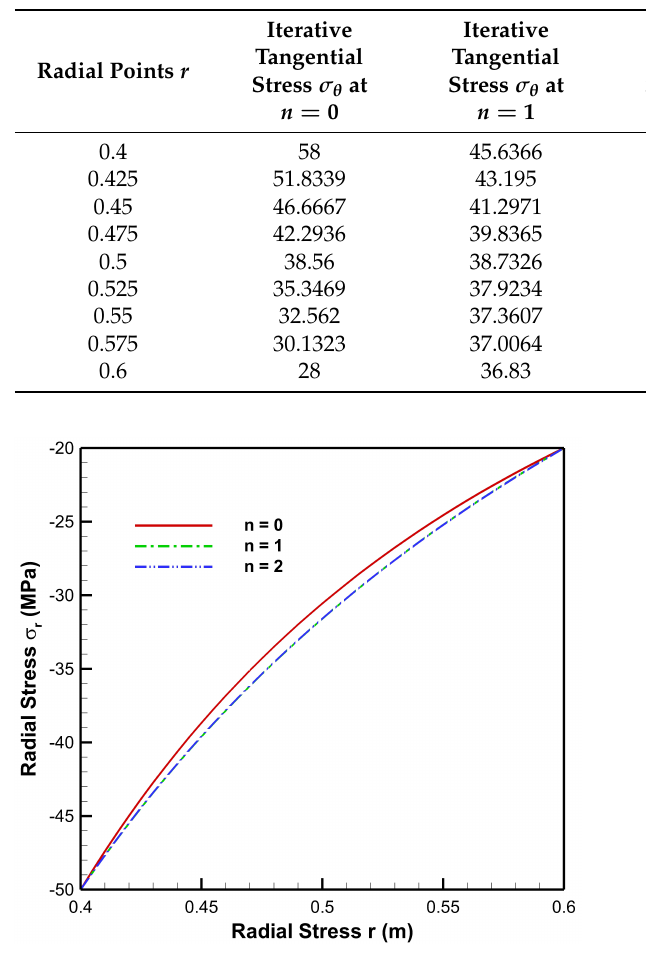
Figure 19. Iterative radial stress σ θ in FGM cylinder at n = 0, n = 1 and n = 2 iterations under internal pressure, P a = 50 MPa and external pressure, P b = 20 MPa.